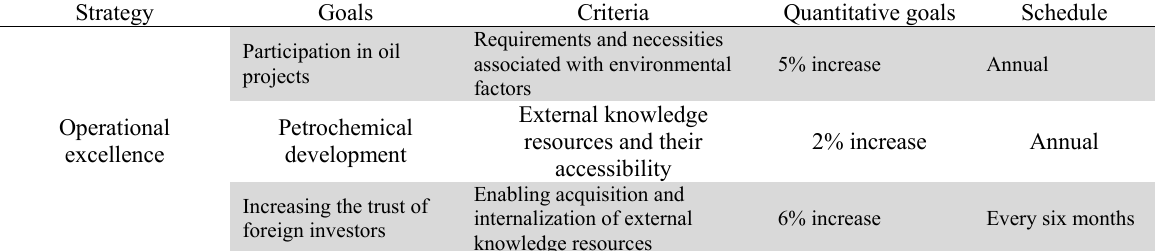
BSC for the environment and society dimension in knowledge management evaluation in petrochemical